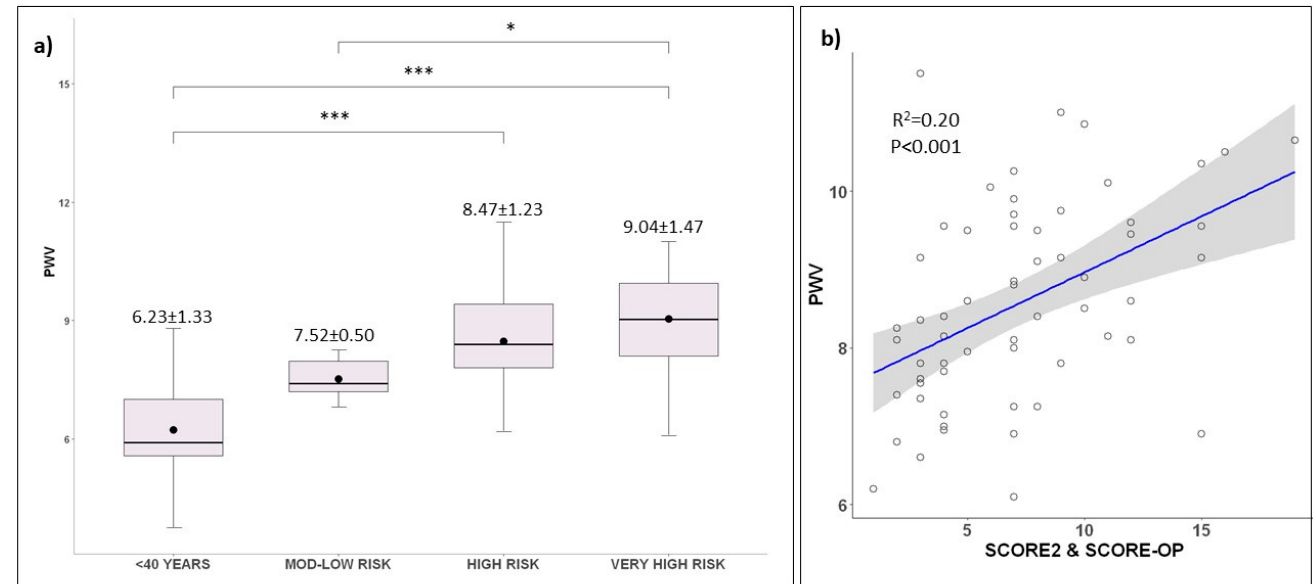
Figure 3. Macrovascular damage and risk categories. ( a ) Boxplot of risk categories and PWV (ANOVA; p < 0.001). Black dots represent the mean. Asterisks represent adjusted significant post hoc Tukey test between groups (* p < 0.05, *** p < 0.001). Post hoc Tukey pairwise comparations: <40 years vs. low-to-moderate risk: p = 0.06, <40 years vs. high risk: p < 0.001, <40 years vs. very high risk: p < 0.001, low-to-moderate risk vs. high risk: p = 0.20, low-to-moderate risk vs. very high risk: p = 0.01, high risk vs. very high risk: p = 0.34. ( b ) Regression model of PWV and SCORE2 and SCORE-OP ( p < 0.001). Blue line represents regression line of best fit. The grey bands around the line represent 95% confidence intervals. Table 1. Baseline characteristics stratified by risk categories. Table 2. Clinical characteristics of participants with low-to-moderate CV risk stratified by platelet EV